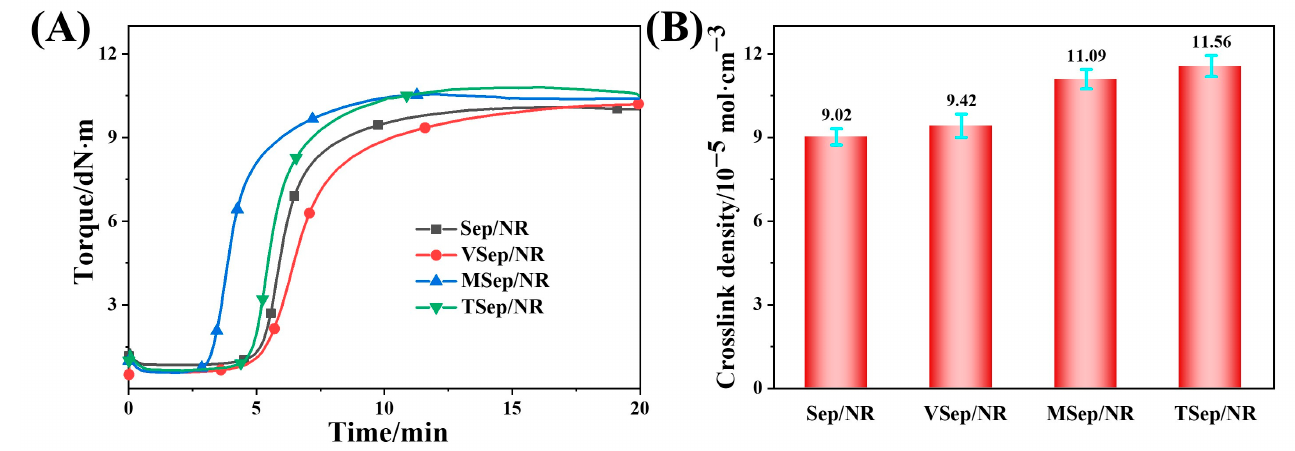
Figure 8. Characteristics of sepiolite/NR composites: ( A ) the curing curves and the ( B ) crosslinking density. ing density. Table 4. The curing characteristics of sepiolite/NR composites.